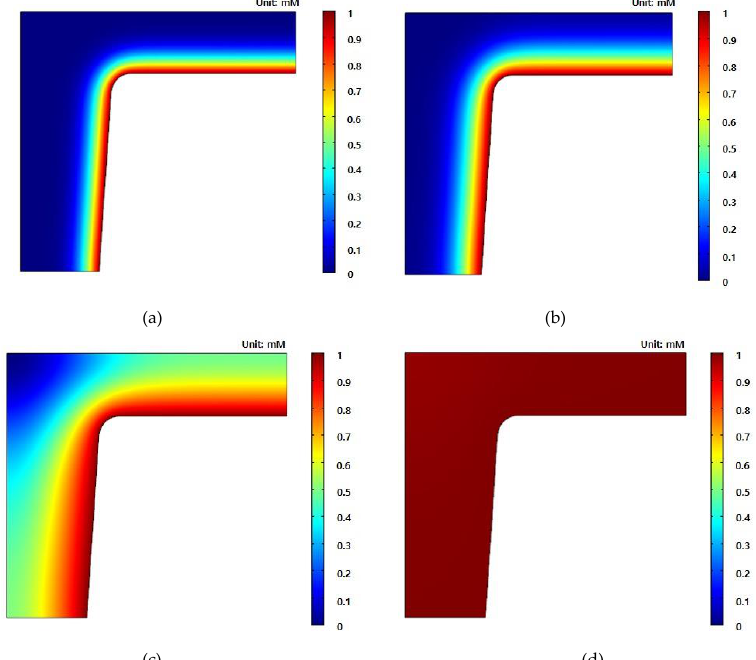
Figure 7. Concentration profile of a cylindrical bead nanostructure with time: ( a ) 1 s; ( b ) 5 s; ( c ) 10 s; ( d ) 120 s.